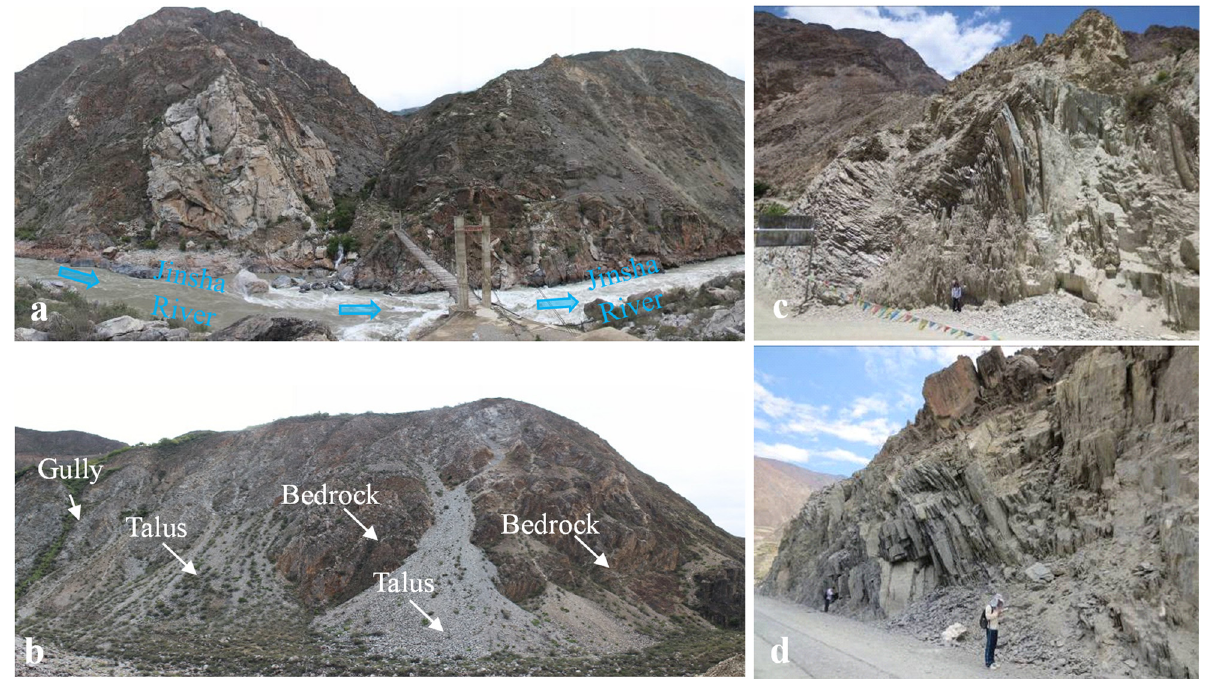
Figure 7. The rock mass structure characteristics and topographic characteristics of the study area, and the deformation characteristics of the rock mass in the study area. ( a ) Rock mass structure char- acteristics, ( b ) topographic characteristics, and ( c , d ) the deformation characteristics of the rock mass.